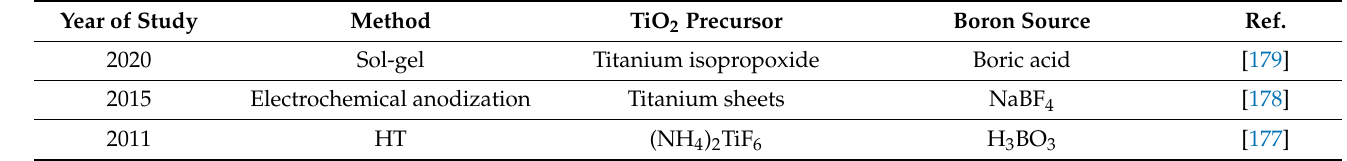
Figure 11. ( a ) Photocatalytic degradation of 4-nitrophenol using B/TiO 2 and undoped TiO 2 . ( b ) First-order plot of photocatalytic degradation of 4-nitrophenol using UV-visible-light irradiation in the presence of BdT and undoped TiO 2 [171]. Table 8. Summary of B/TiO 2 photocatalysts synthesized by variety of methods and source precur- sor materials.